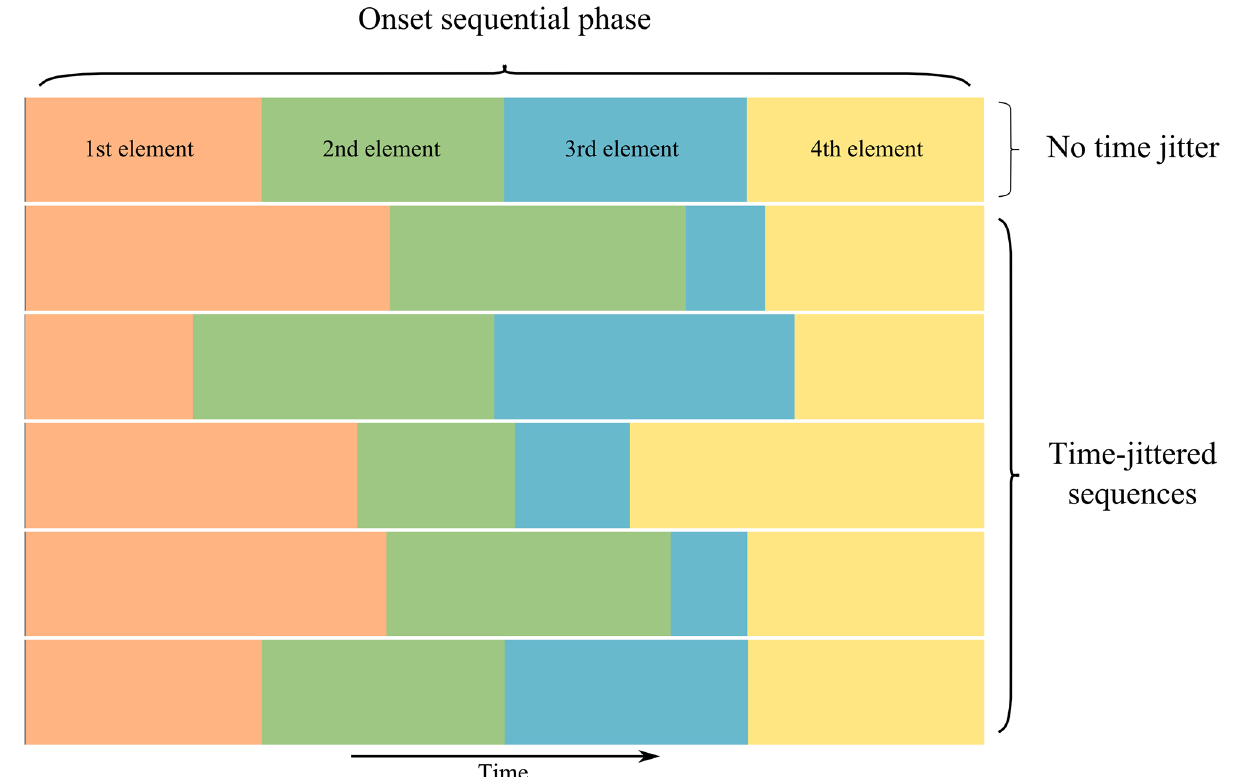
Fig 9. Time-jittered KC activity from the model. Using one connectivity matrix, we generated PN data with no jitter and used that data to create time- jittered PN activity. The KC activity output by our model is shown: each row represents a sequence displayed by our model; each color represents a cluster in the sequence. The first sequence (top) has no time-jitter in the input. The following sequences are time-jittered, i.e. the time each cluster is active is different. It can be readily seen that the Bayesian inference has no trouble handling time-jitter that cannot be generated directly by the generative